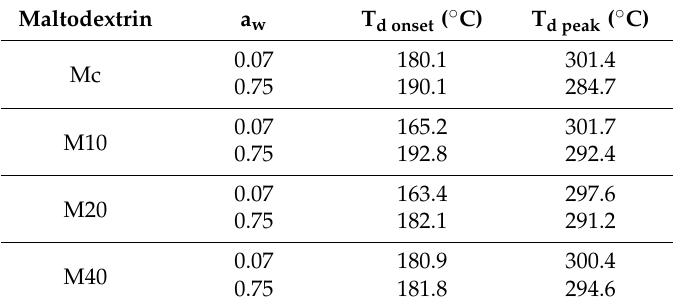
Figure 3. Thermal decomposition of MXs. TGA and DTG curves for: ( a ) Mc; ( b ) M10; ( c ) M20, and ( d ) M40. Table 3. Thermal decomposition temperatures of MXs at the extreme water activities (a w ), determined from TGA-DTG curves in Figure 3.